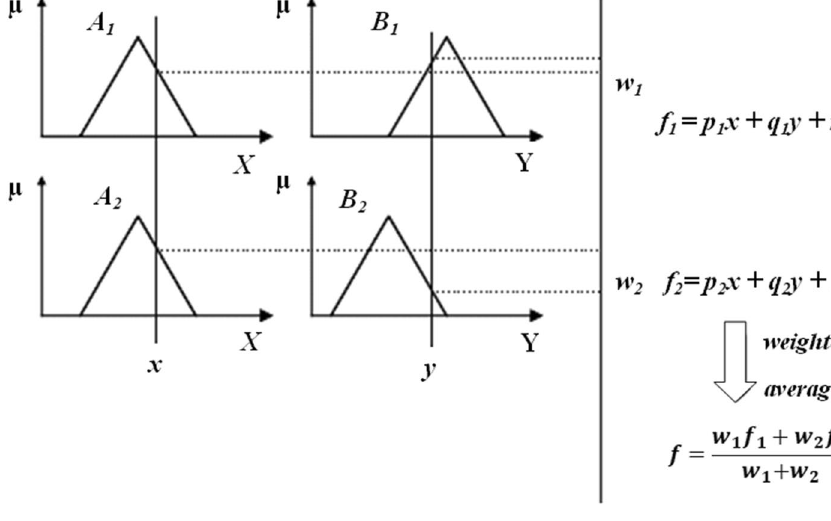
Fig. 14 Equivalent ANFIS